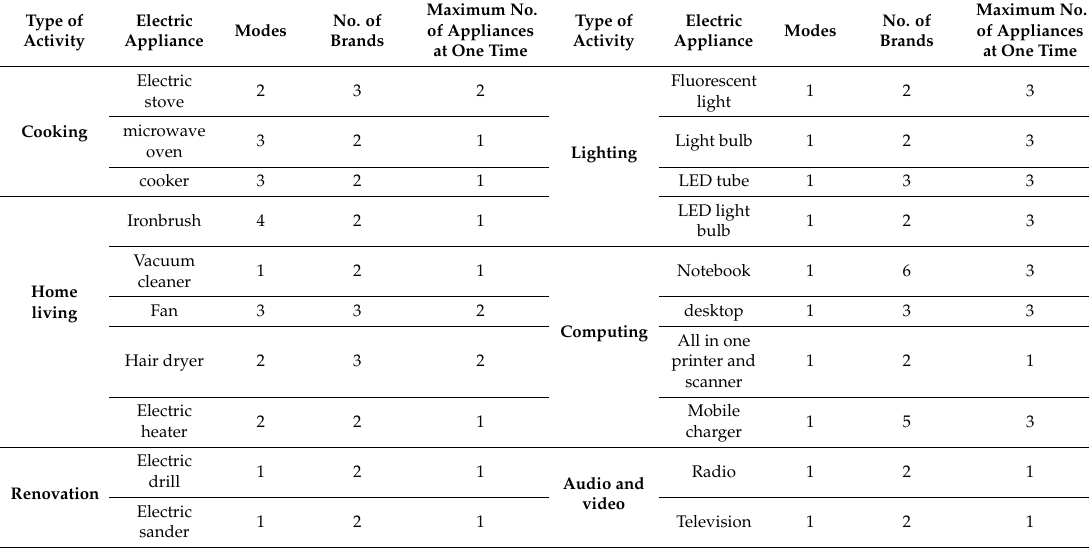
Table 1. List of electric appliances that have been analyzed.